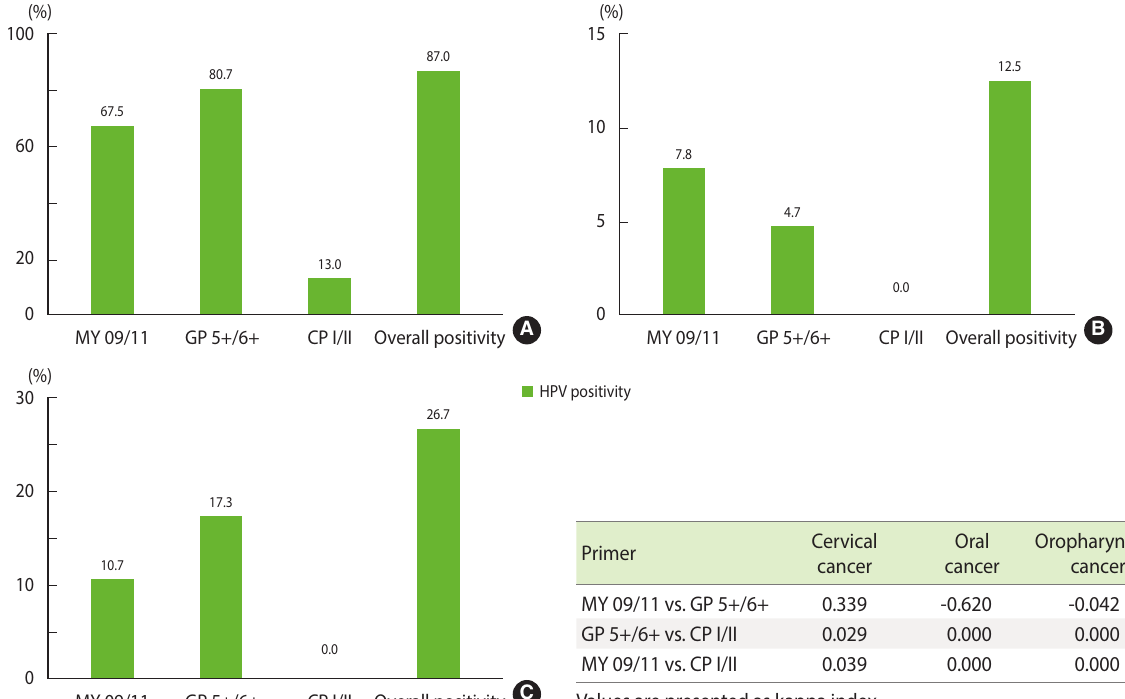
Figure 1. Representative patterns of gel electrophoresis of polymerase chain reaction by degenerative primers (A) MY 09/11, (B) GP 5+/6+, and (C) CP I/II.